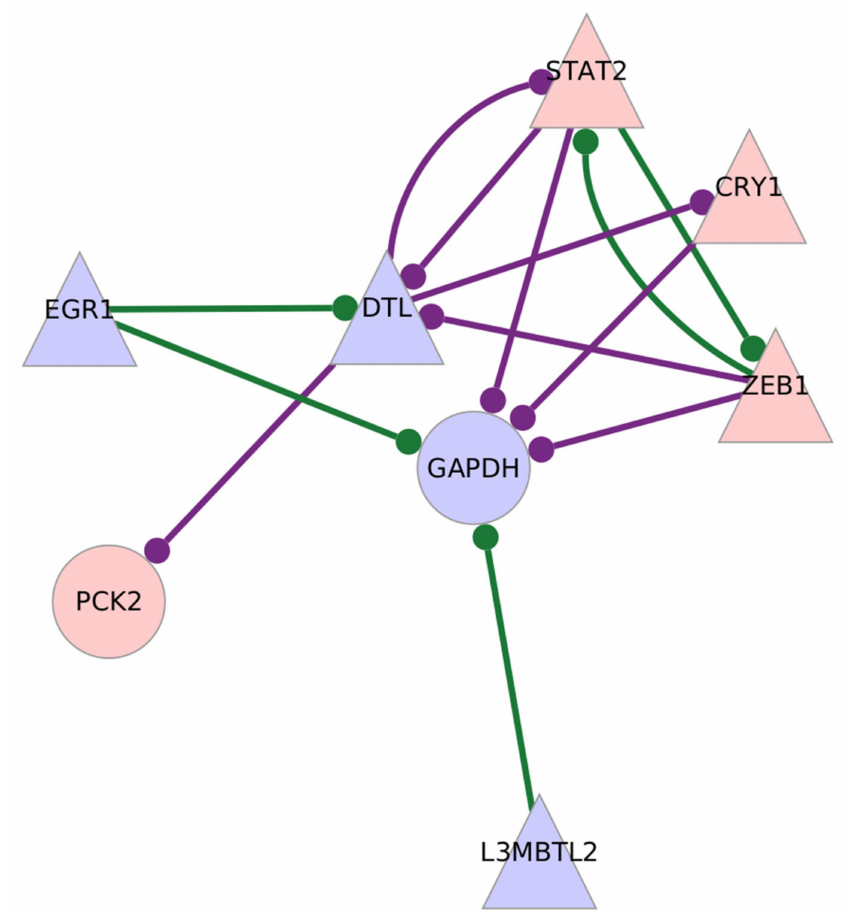
Figure 7. Subgraph of differentially expressed glycolysis-related enzymes with high centrality scores in the GTRD-annotated network of edges with significantly different edge weights between tocilizumab-treated RA and untreated RA samples, in CD8 + Tem cells. The differentially expressed transcription factors that link to the enzymes are shown. Triangles indicate transcription factors, and circles indicate target genes. Node colour shows the direction of differential expression: red nodes are over-expressed and blue nodes are under-expressed. The presence of an edge between a TF and a target gene refers to a significant difference in the edge weights of that gene pair between untreated RA samples and healthy samples. Purple edges show higher edge weight in RA, and green shows higher edge weight in healthy